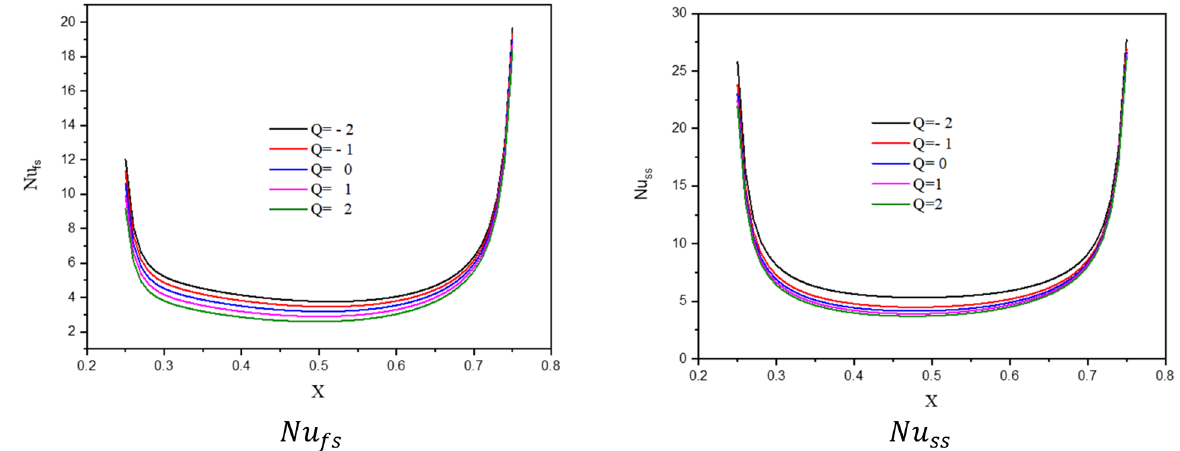
Figure 5. Profiles of the Nu fs and Nu ss , along the heat source below the changes on heat generation/ absorption coefficient Q for a hybrid nanofluid for at φ Cu ε = 0.5, Da = 10 − 3 , Ha = 10, k fs = 1, D = 0.5, k r = 1, H ∗ = 10.